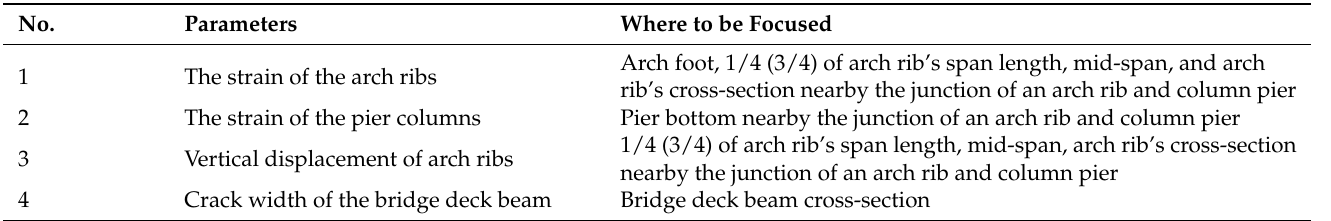
Table 2. Multi-parameter